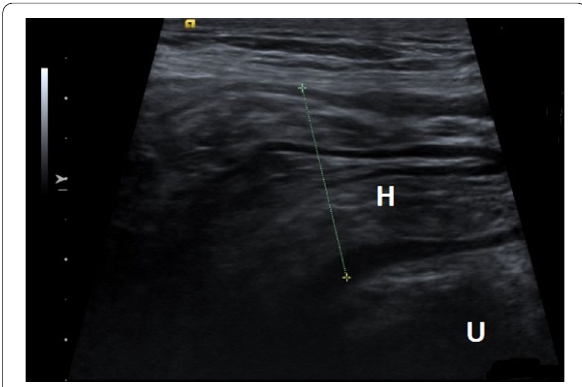
Fig. 1 Illustration of a true positive case. Siemens ACUSON S2000 with a linear array probe 9L4 H8.00 MHz. H hernia, U urinary bladder